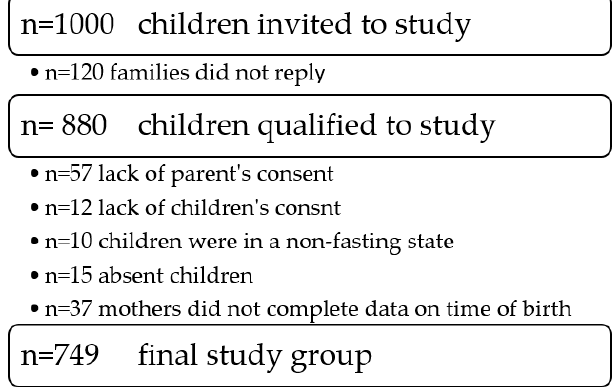
Figure 1. The flow chart of participants.